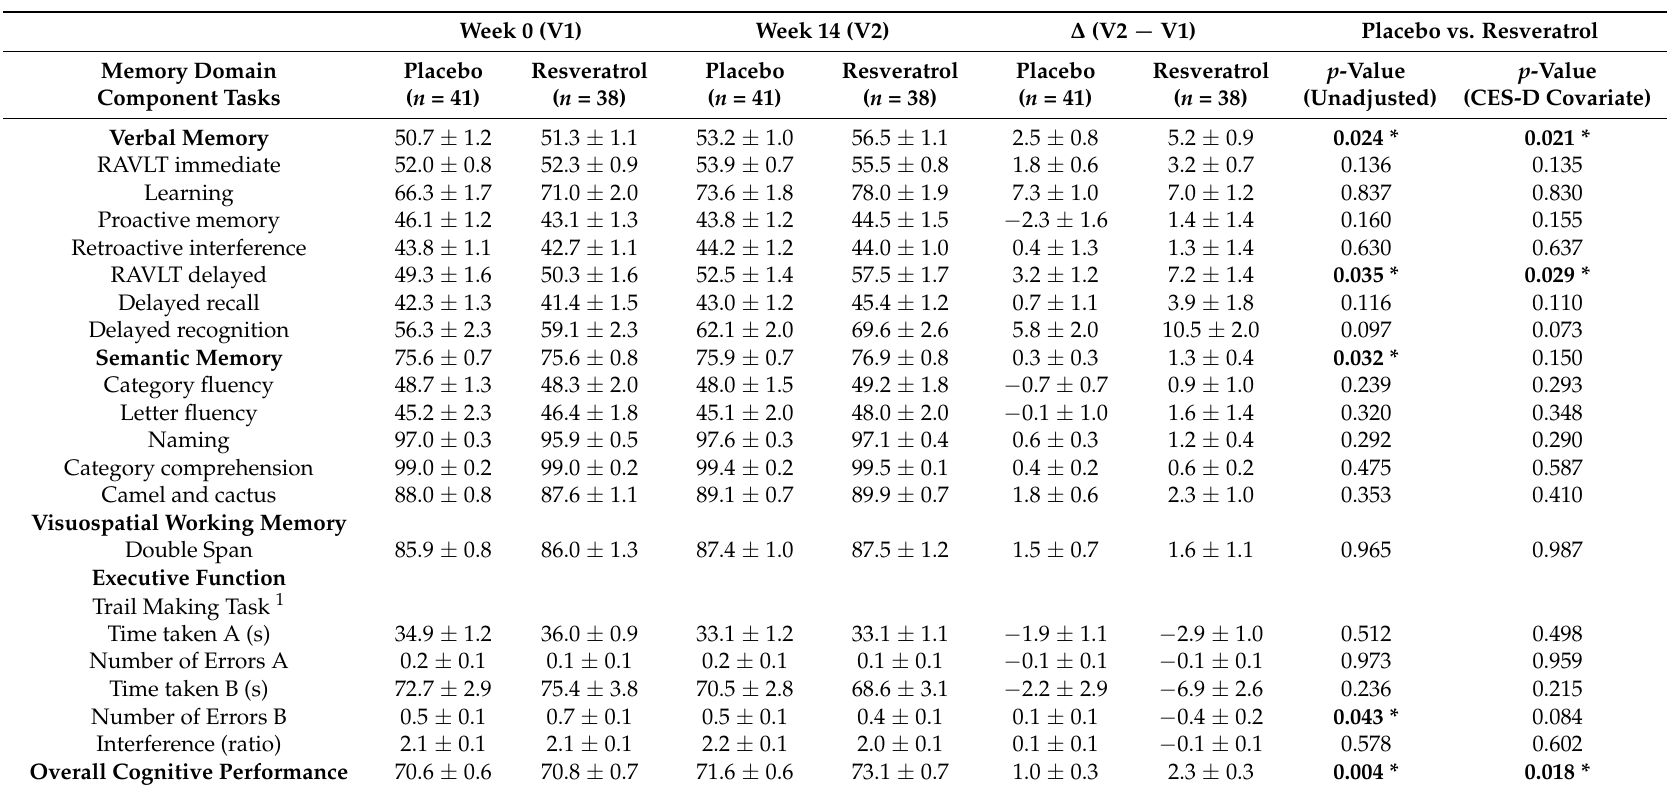
Table 2. Participants’ raw performance data (percentage) for each cognitive component. Data are presented as mean ±